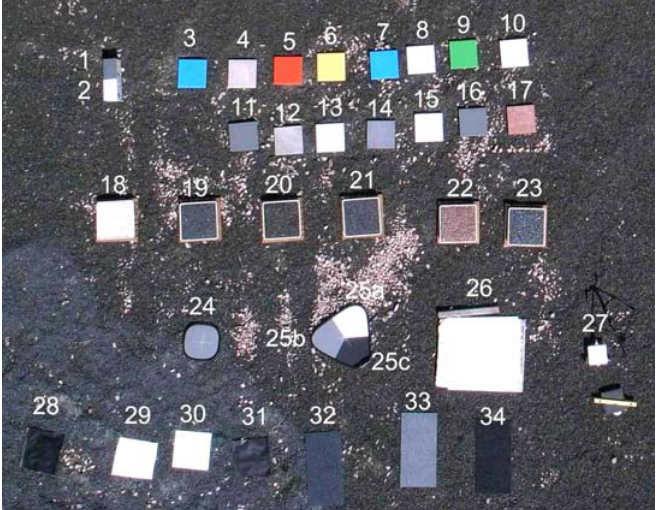
Figure 6. Targets used for reflectance factor validation measurement. Targets 1–2 are light gravel brick painted with gray and white paint, 3–17 are concrete tiles painted with various paints or left unpainted, 18–23 are gravel samples from the Sjökulla test field, 24–27 are reference targets, 28–31 are plastic tarps painted with various black or white paints, and 32–34 are pieces of commonly available carpets.